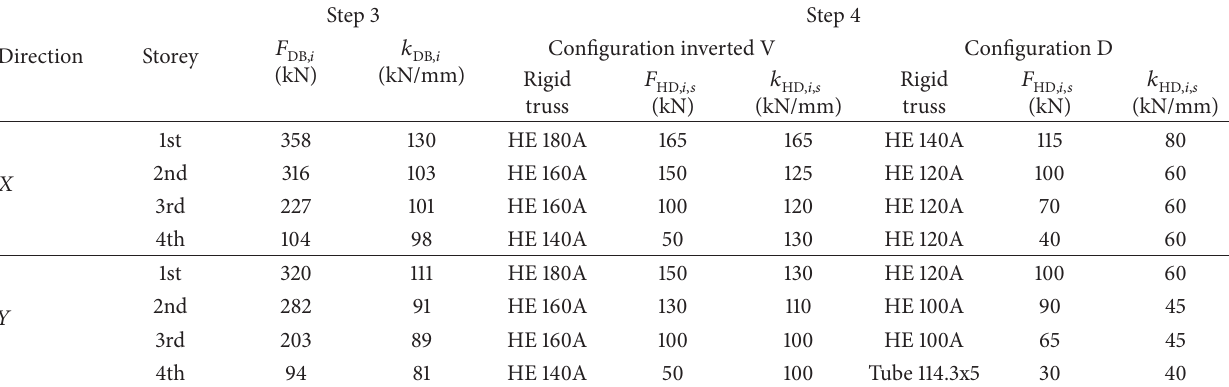
Table 4: Characteristics of the dissipative